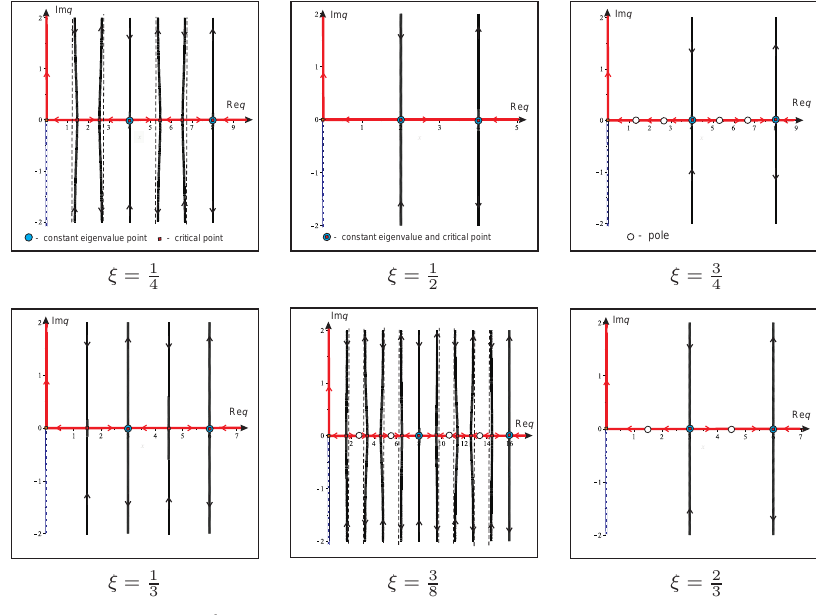
for various ξ N